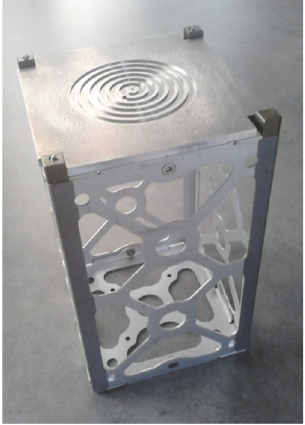
Figure 5: The Bull’s Eye antenna on a CubeSat chassis